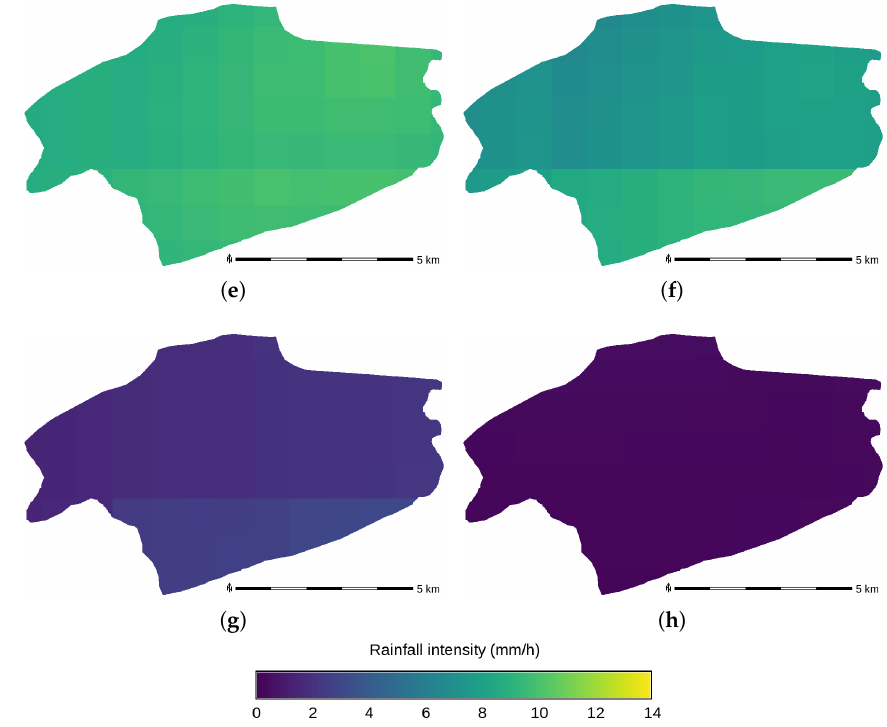
Figure 6. Evolution of rainfall intensity above the study area obtained with Kriging with External Drift. Event of 25 June 2007. ( a ) 00:00–01:00; ( b ) 03:00–04:00; ( c ) 06:00–07:00; ( d ) 09:00–10:00; ( e ) 12:00–13:00; ( f ) 15:00–16:00; ( g ) 18:00–19:00; ( h ) 21:00–22:00.